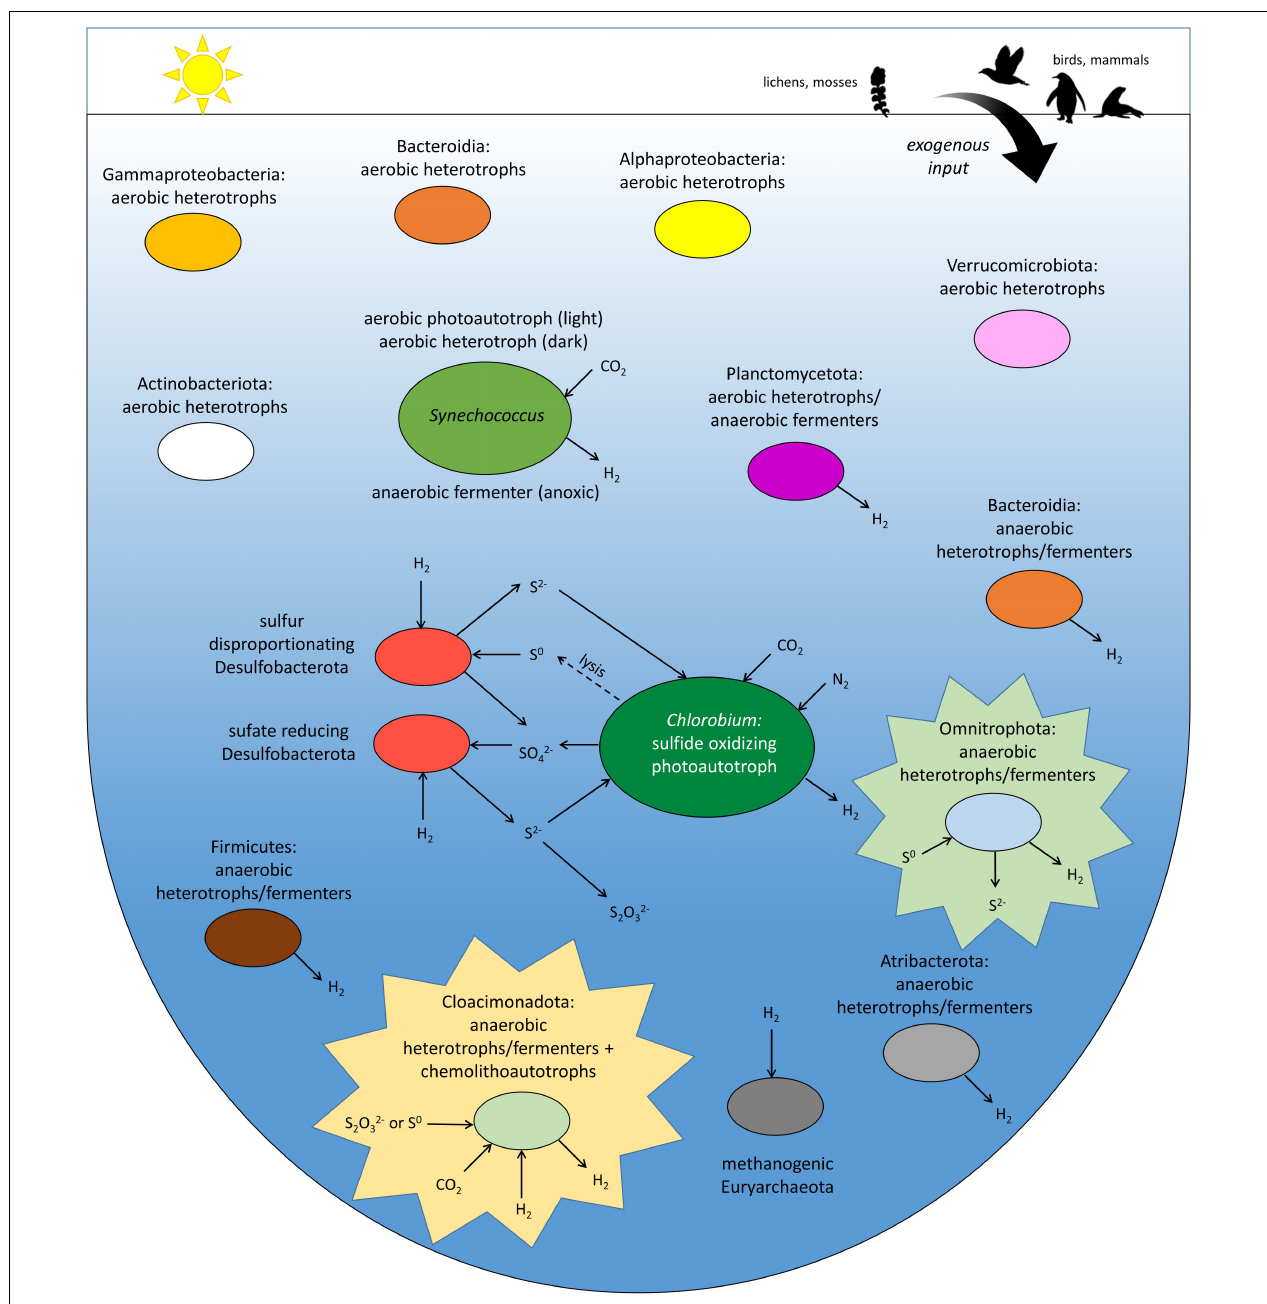
FIGURE 5 | Depiction of the most abundant bacteria and archaea in Ace Lake in the austral summer. Sulfur and hydrogen cycles are emphasized. Sizes of the ellipses that represent individual clades are approximately proportional to their peak relative abundance in the lake (Panwar et al., 2020), with Chlorobium (Chlorobia) the most abundant and Synechococcus (Cyanobacteria) the second most abundant. Chlorobium marks the oxic–anoxic interface of the lake. The candidate phyla Cloacimonadota and Omnitrophota are highlighted. Different taxa within candidate phylum Cloacimonadota are inferred to be capable of hydrogen and sulfur oxidation for chemolithoautotrophic growth; hydrogen is produced during heterotrophic growth. All taxa within the Omnitrophota candidate phylum are inferred to generate hydrogen, but only some are inferred to generate sulfide. Animal and plant silhouettes are courtesy of PhyloPic (http://phylopic.org/).